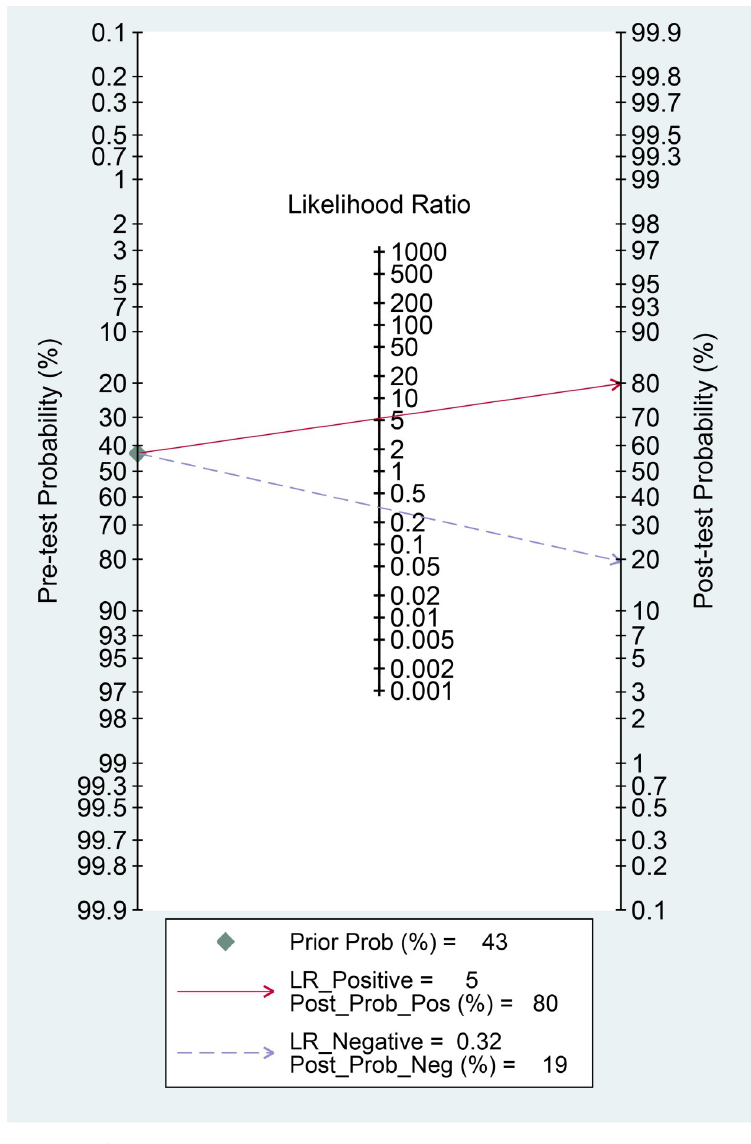
Fig 2. Fagan’s nomogram for FIB-4 > 3.85 and